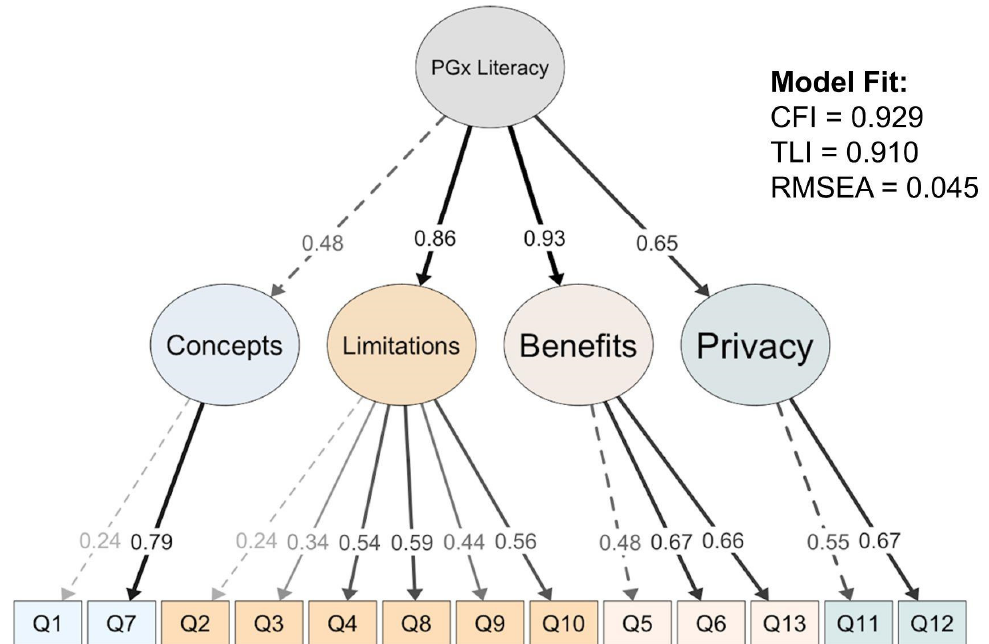
Figure 5. Confirmatory factor analysis (CFA) using structural equation model for the 13-item MAPL.